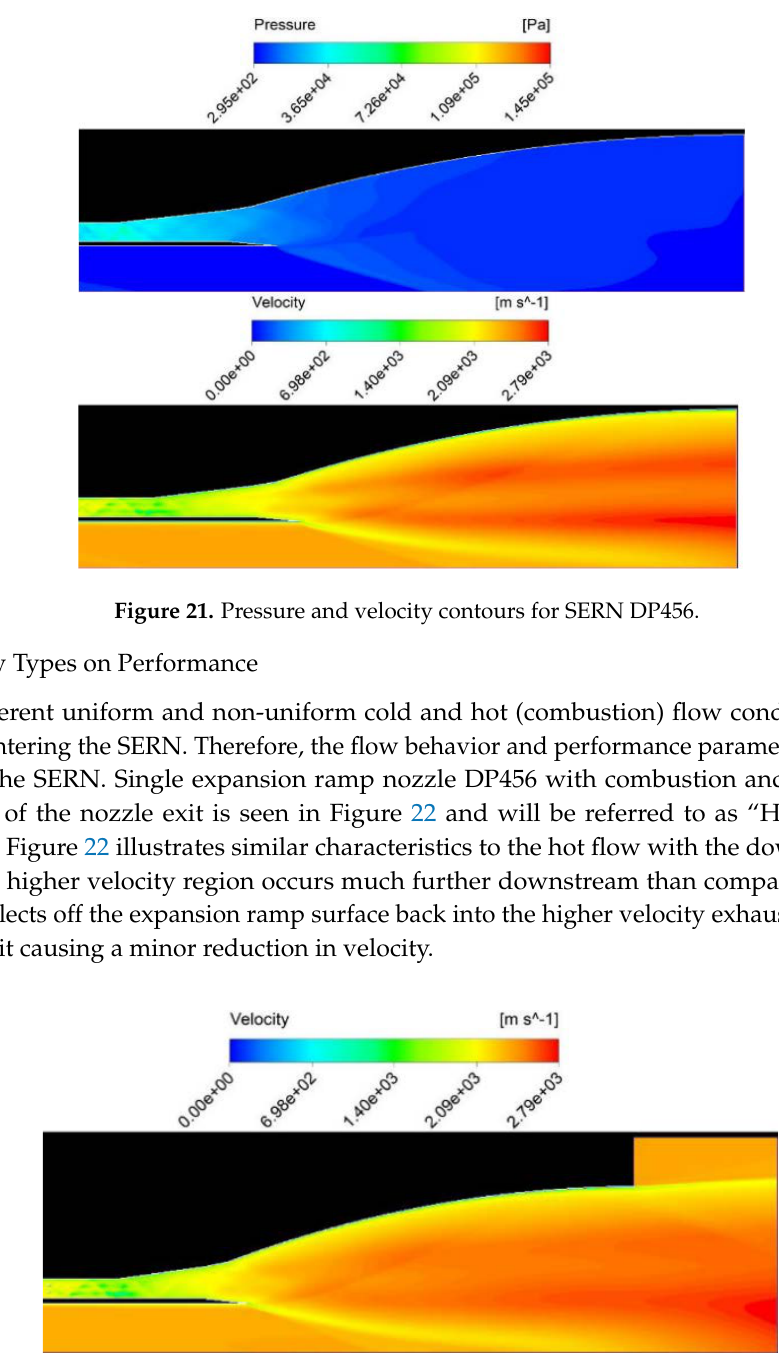
Figure 22. Velocity contour of SERN DP456 with combustion at 10 m downstream of the SERN exit.